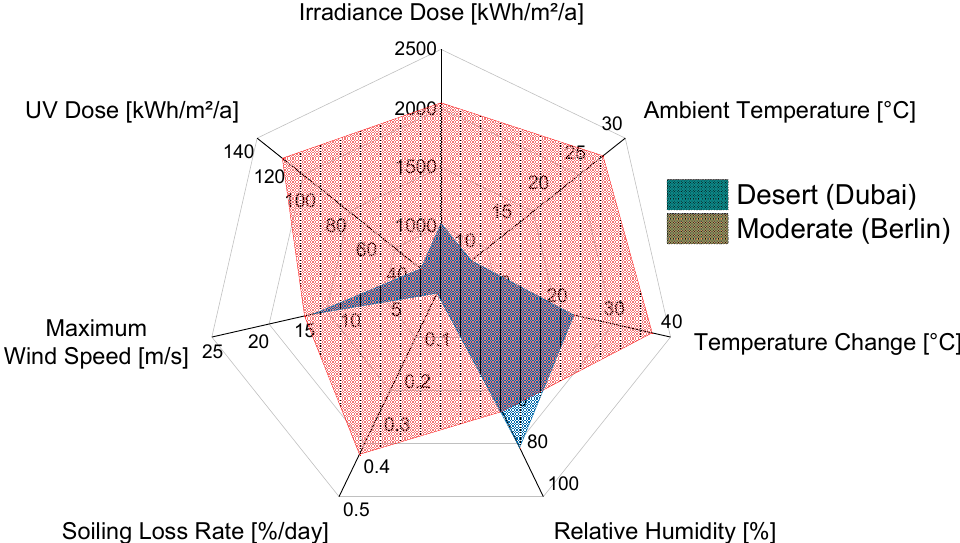
Figure 1. Comparison of environmental stress factors between moderate (Halle, Germany) and desert (Dubai, United Arab Emirates) climates.